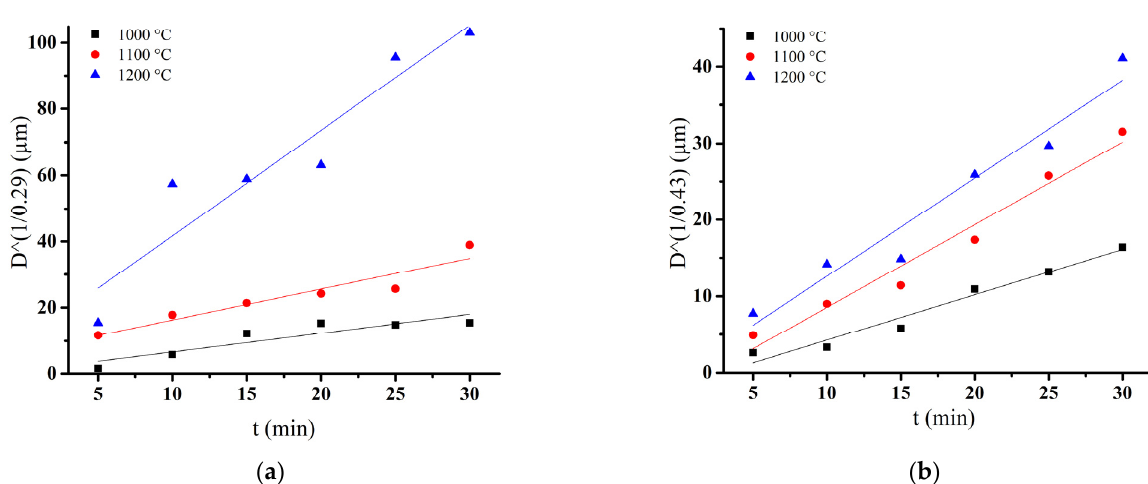
( b ) Figure 5. The linear fit dependences of iron grain average Feret diameter on temperature in the LnD − Lnt plot for the RM roasting without additives ( a ) and with 13.65% Na 2 SO 4 ( b ).